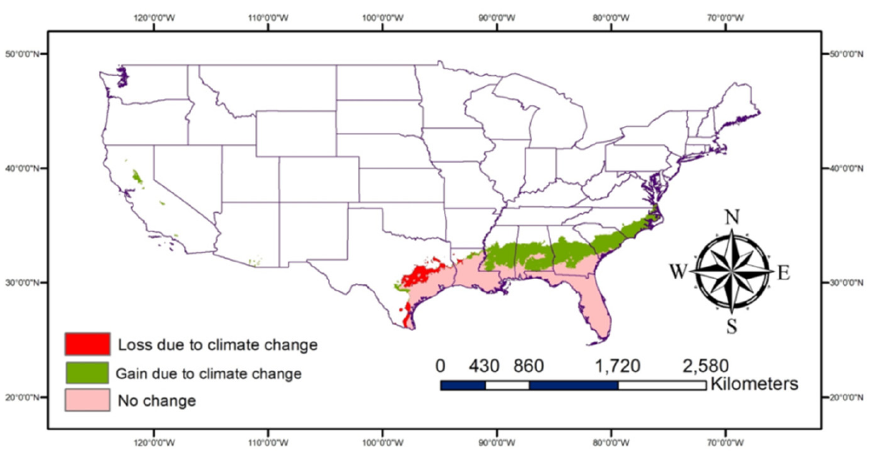
Figure 7. Map showing changes in the very highly suitable areas due to climate change.